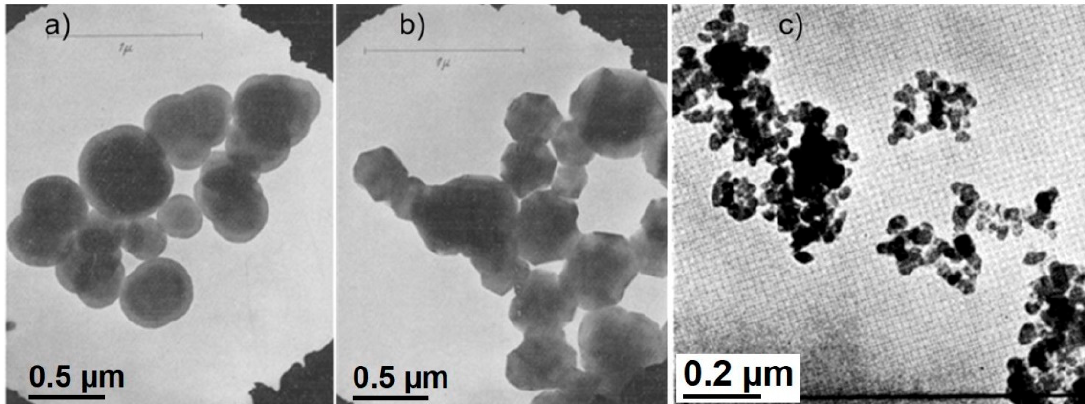
Figure 3. Historical TEM images obtained for carbon black. ( a ) Unheated and ( b ) heat-treated at 3000 °C thermal carbon black consisting of individual nanospherules. Figures reprinted with permission from Hofmann and Höper [5]. Copyright (1944) Springer Nature. ( c ) Unheated channel carbon black (Spheron grade 6) consisting of aggregates. Reproduced with permission from Hall [5]. Copyright AIP Publishing, 1948.